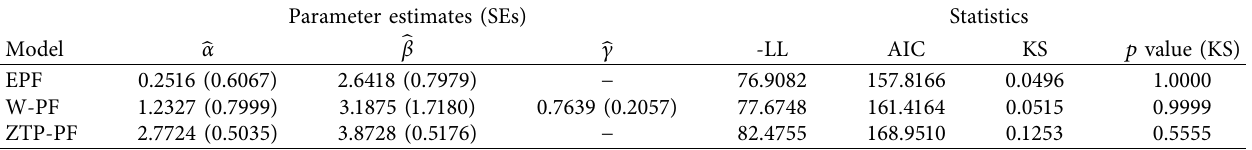
Table 10: Parameter estimates, SEs, and goodness-of-fit statistics for turbocharger data.